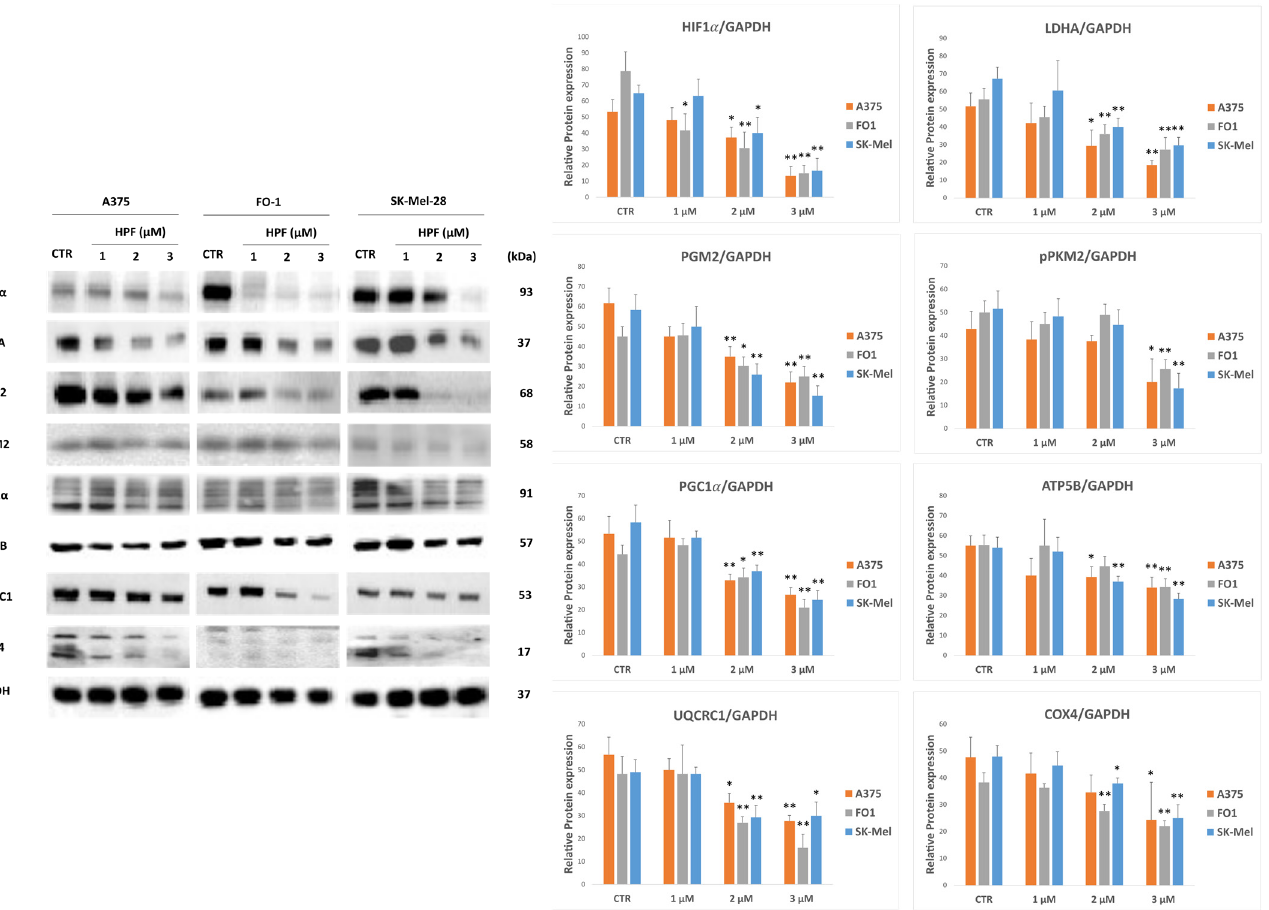
Figure 7. Hyperforin affects the expression levels of key proteins involved in cytosolic and mito- chondria metabolic pathways. Represented immunoblots show the expression level of key proteins involved in melanoma cells metabolism after 24 h HPF treatment. In particular, the expression of hypoxia-inducible factor (HIF)-1 α , lactate dehydrogenase A (LDHA), phospho-gluco-mutase2 (PGM2), the phosphorylated form of pyruvate kinase M2 (pPKM2), peroxisome proliferator-activated receptor-gamma coactivator (PGC)-1 α , c1 subunit of the ubiquinol cytochrome c reductase (UQCRC1), ATP synthase F1 subunit β (ATP5B), cytochrome c oxidase subunit IV (COX4) and GAPDH. On the right, histograms represent the mean values ± S.D. of protein expression levels measured by densitometry deriving from three independent experiments and normalized. All comparisons were performed vs. each control sample after data normalization; * p < 0.05; ** p < 0.01. Thus, expression levels of mitochondrial key proteins were measured. The